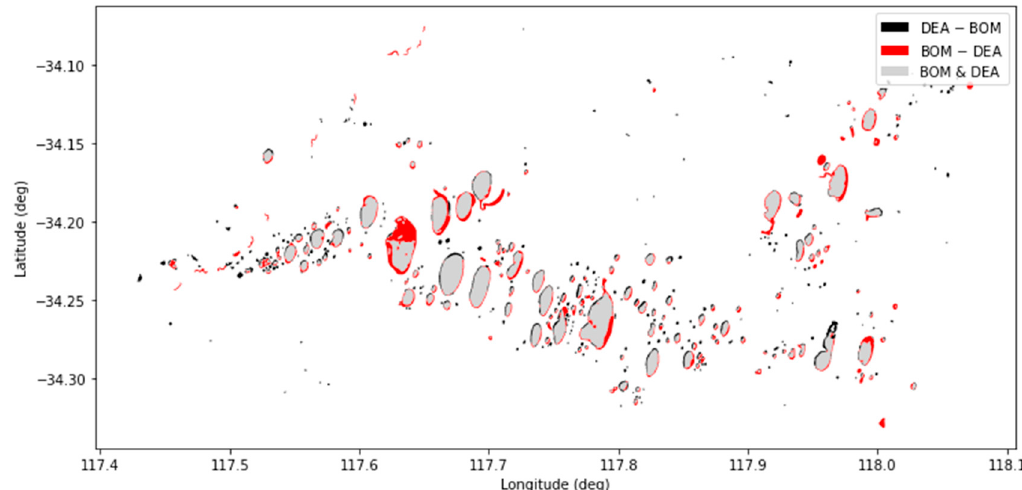
Figure A7. Difference and intersection between DEA Waterbodies and Geofabric in the Cranbrook test area.